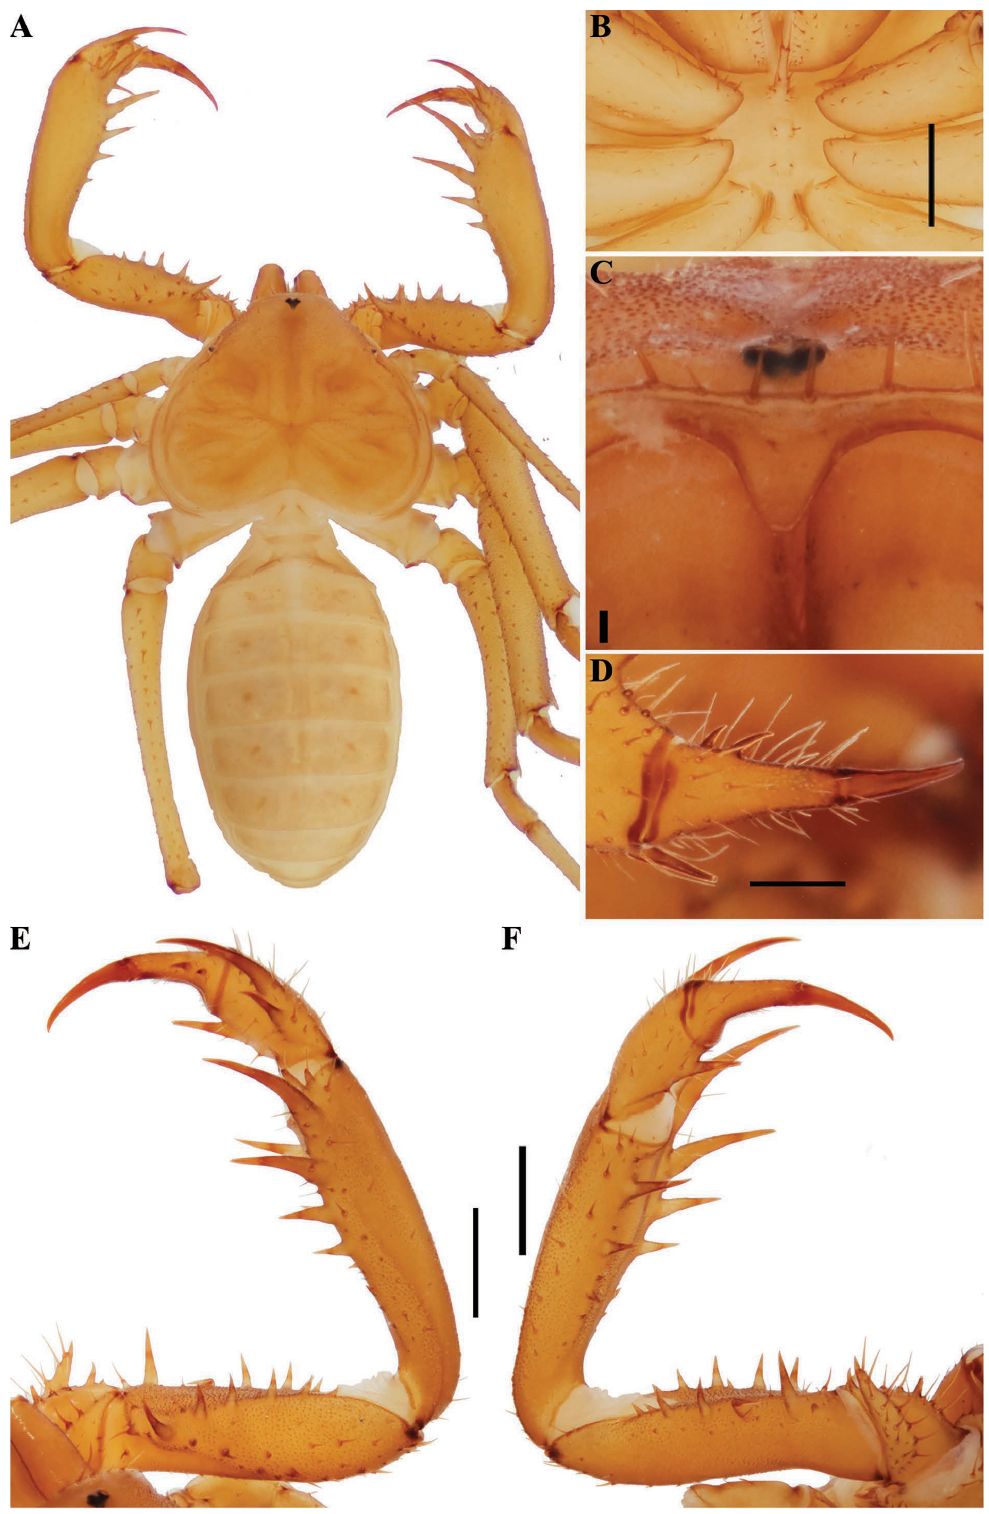
Fig. 142. Sarax ioanniticus (Weygoldt, 2005) comb. nov. (NHMW 19137), general morphology, ♀ . A . Habitus, dorsal view. B . Sternum, ventral view. C . Frontal process. D . Pedipalp tarsus, frontal view. E . Pedipalp, dorsal view. F . Pedipalp, ventral view. Scale bars: A–B, E–F = 1 mm; C = 0.1 mm; D = 0.5